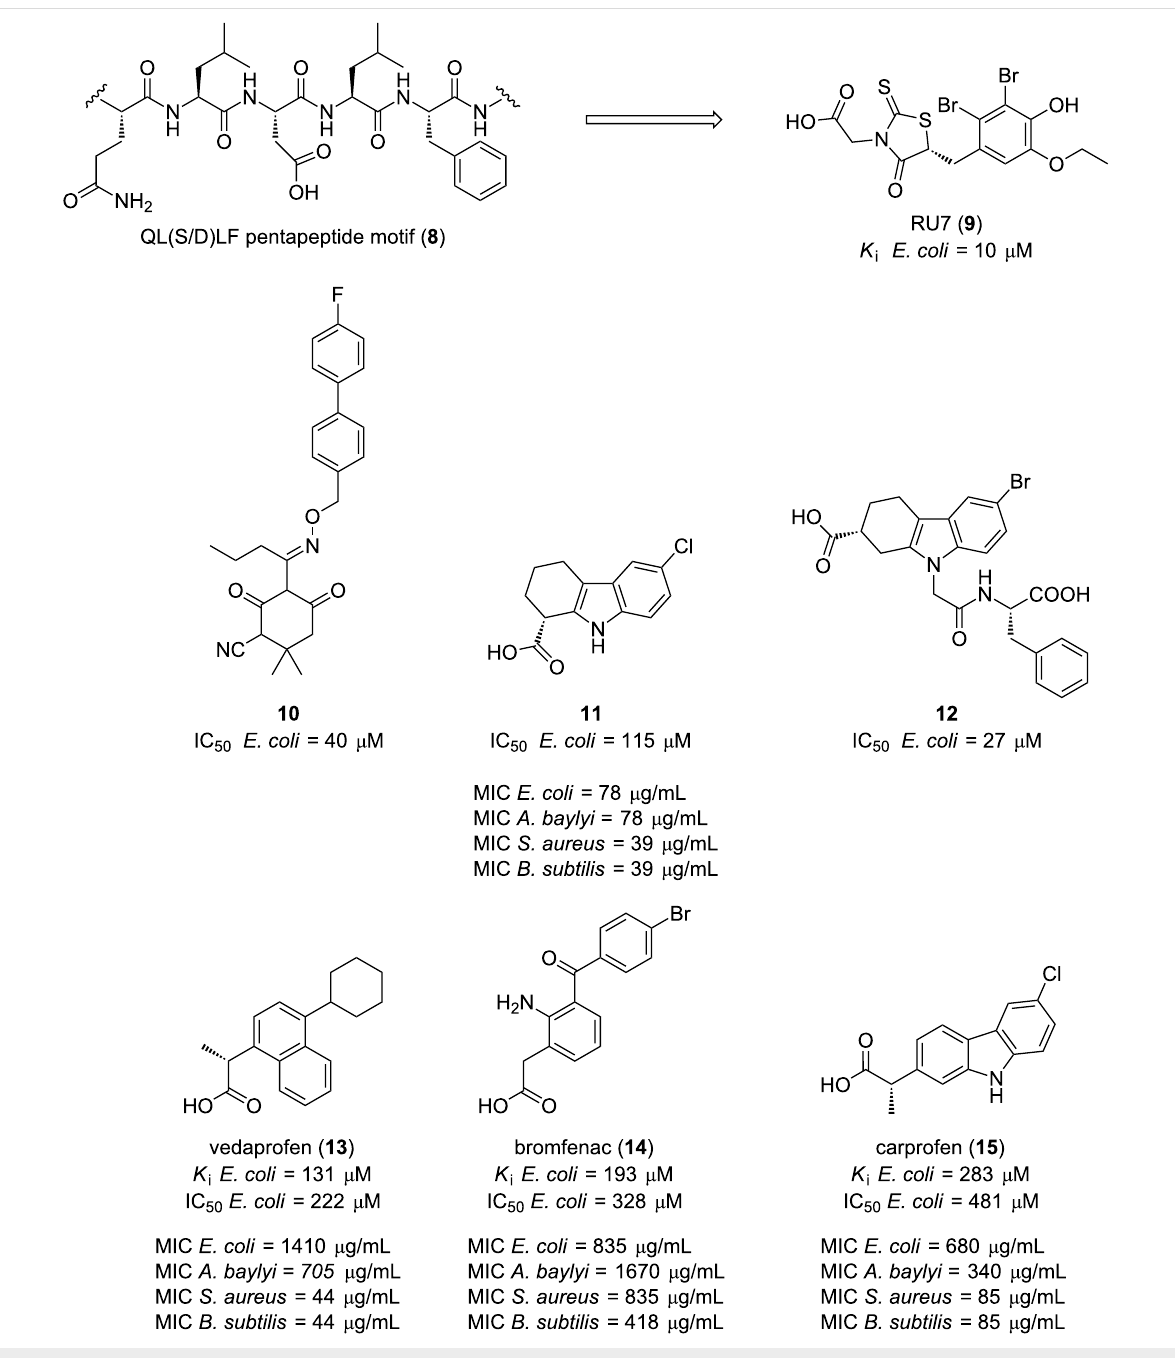
Figure 3: Small-molecule inhibitors of PPIs in the β -sliding clamp.